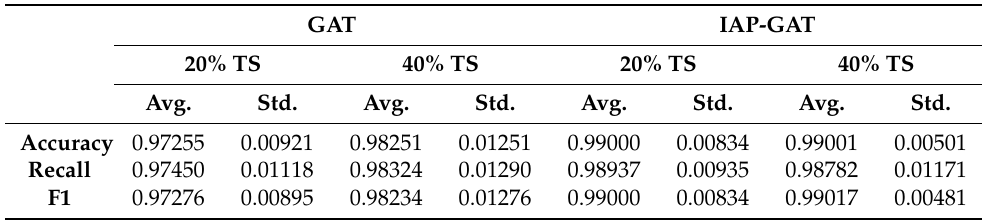
Table A1. Average and standard deviation values of the performance recorded in GAT’s and IAP- GAT’s 10 runs on LUSC and HNSC with 20% and 40% training